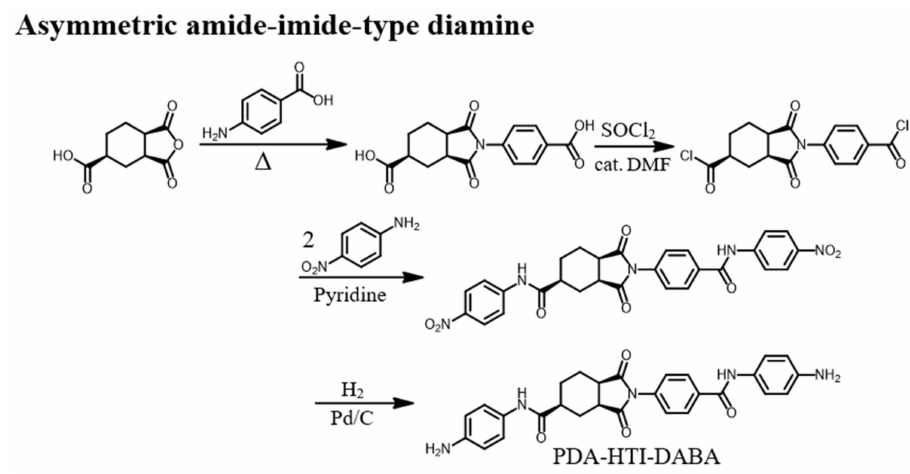
Figure 2. Reaction scheme for the synthesis of asymmetric amide-imide-type diamine. In a three-necked flask, the dicarboxylic acid obtained (3.96 g) was converted